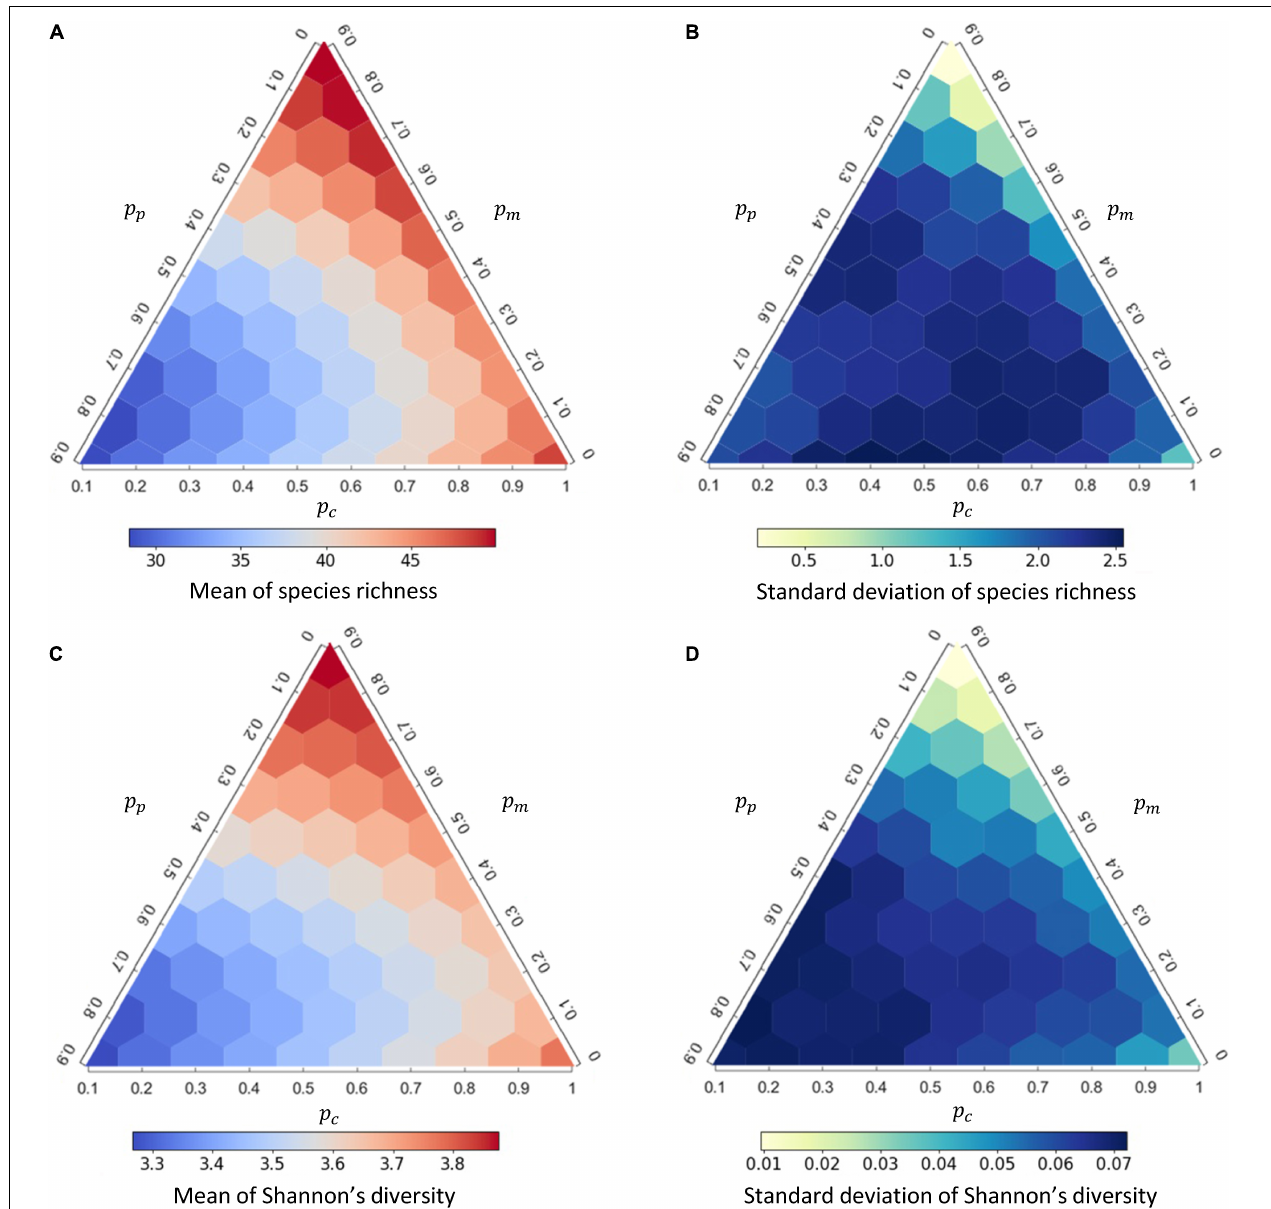
FIGURE 3 | The responses of species richness and Shannon’s diversity, respectively, to interaction composition under density-dependent (DD) disease transmission. (A,B) effects of interaction compositions on the mean and standard deviation of species richness; (C,D) effects of interaction compositions on the mean and standard deviation of Shannon’s diversity. See Supplementary Figure 7 for the corresponding figure under frequency-dependent (FD)